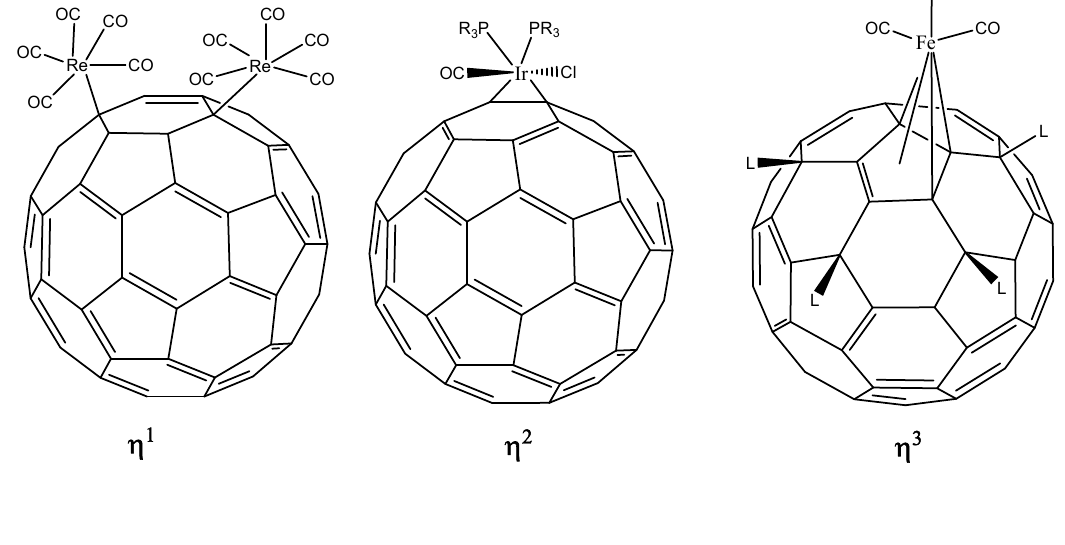
Figure 2. Presenting all possible hapticities for fullerene C